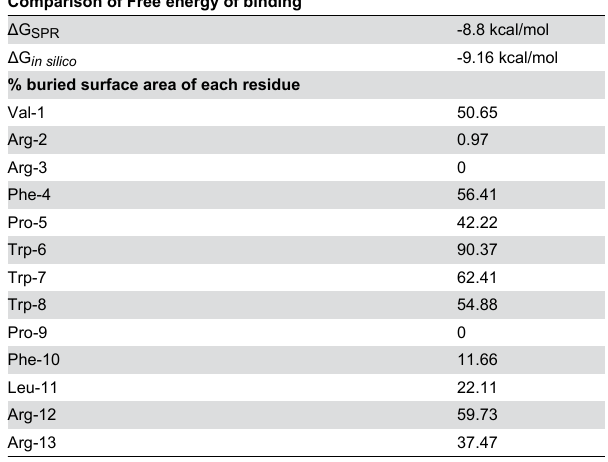
Table 4. Comparison of Gibbs free energy of binding of tritrpticin to mAb 6C6D7 as obtained by computational and SPR based studies and percent buried surface area of each residue of tritrpticin during interaction with mAb 6C6D7as calculated by